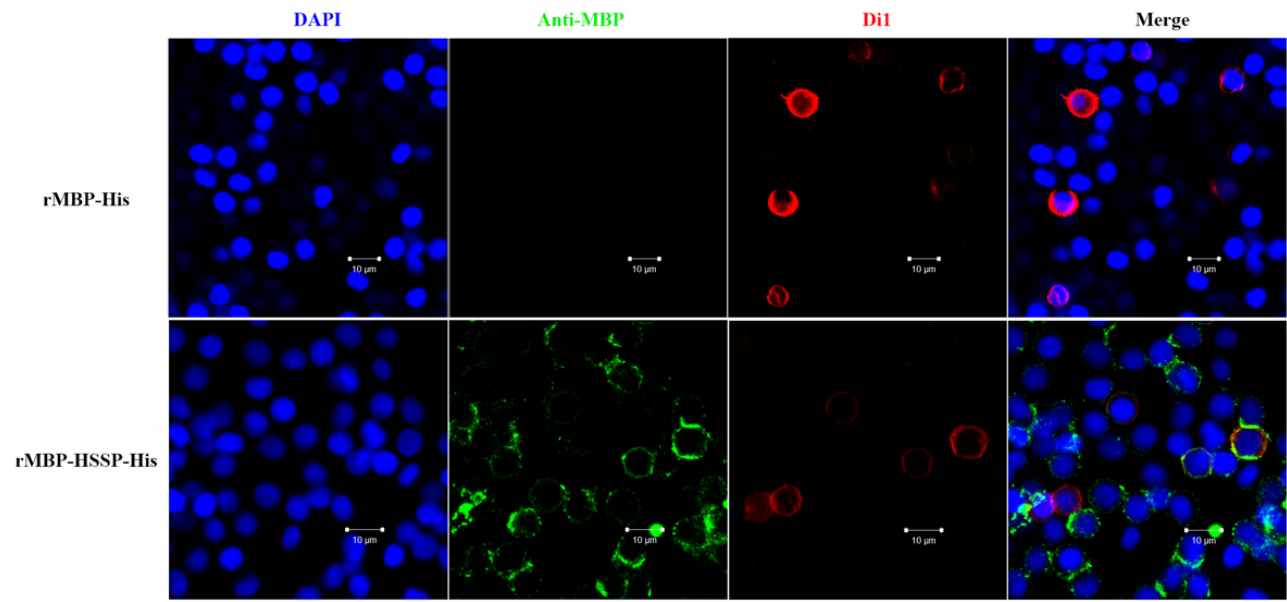
Figure 8. Co-location of LvHSSP protein and the hemocytes. rMBP-His represents the results of MBP tag protein, and rMBP-HSSP-His represents the results of LvHSSP recombinant protein. The blue signal of DAPI indicates the nucleus, the green signal of anti-MBP indicates the positive signals of target proteins, the red signal of Di1 indicates the membrane, and the last lanes are the merged picture of previous three signals. Bar = 10 µm.